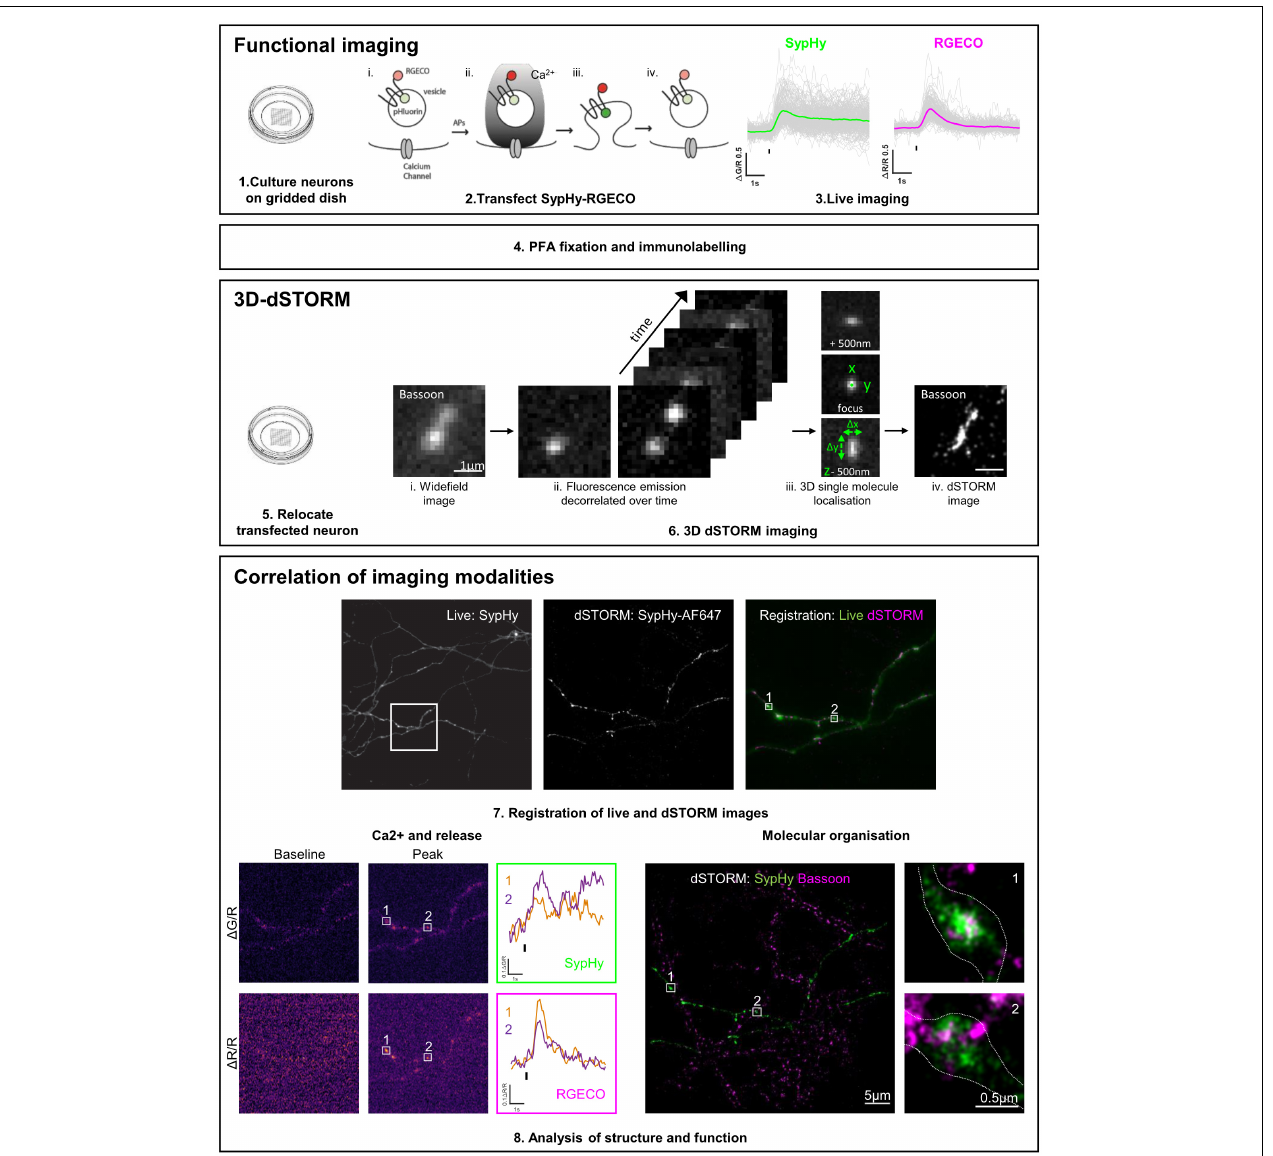
FIGURE 1 | Functional and 3D-dSTORM correlative imaging pipeline. (1–3) Preparation of neurons for functional imaging of a presynaptic calcium and vesicle release sensor (SypHy-RGECO). (4) Fixation and immunolabelling of neurons. (5–6) Relocation and super-resolution (dSTORM) imaging of SypHy-RGECO + ve neurons. (7–8) Registration between imaging modalities, analysis of calcium influx (RGECO) and neurotransmitter release (SypHy) and nanoscale organisation of synaptic proteins (dSTORM), followed by single synapse correlation between